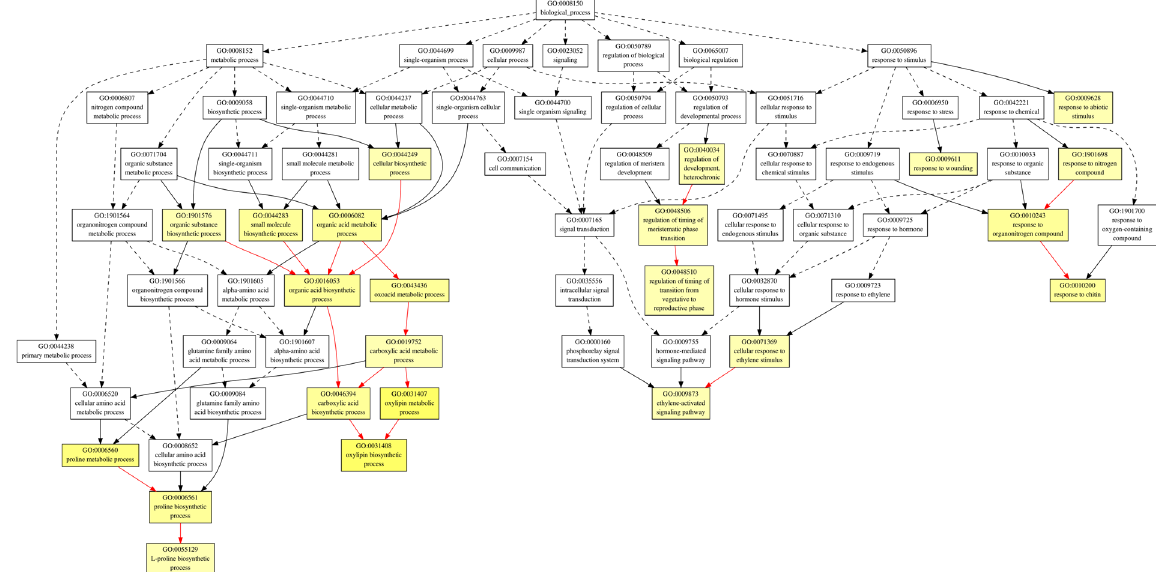
Figure 3. Biological Process (BP) of GO term enrichment for up-regulated common DEGs in A. stolonifera . Yellow color indicates significantly enriched GO terms. The density of color in each node was proportional to statistical significance of enrichment of the corresponding GO term. Red edges stand for relationship between enriched GO terms.